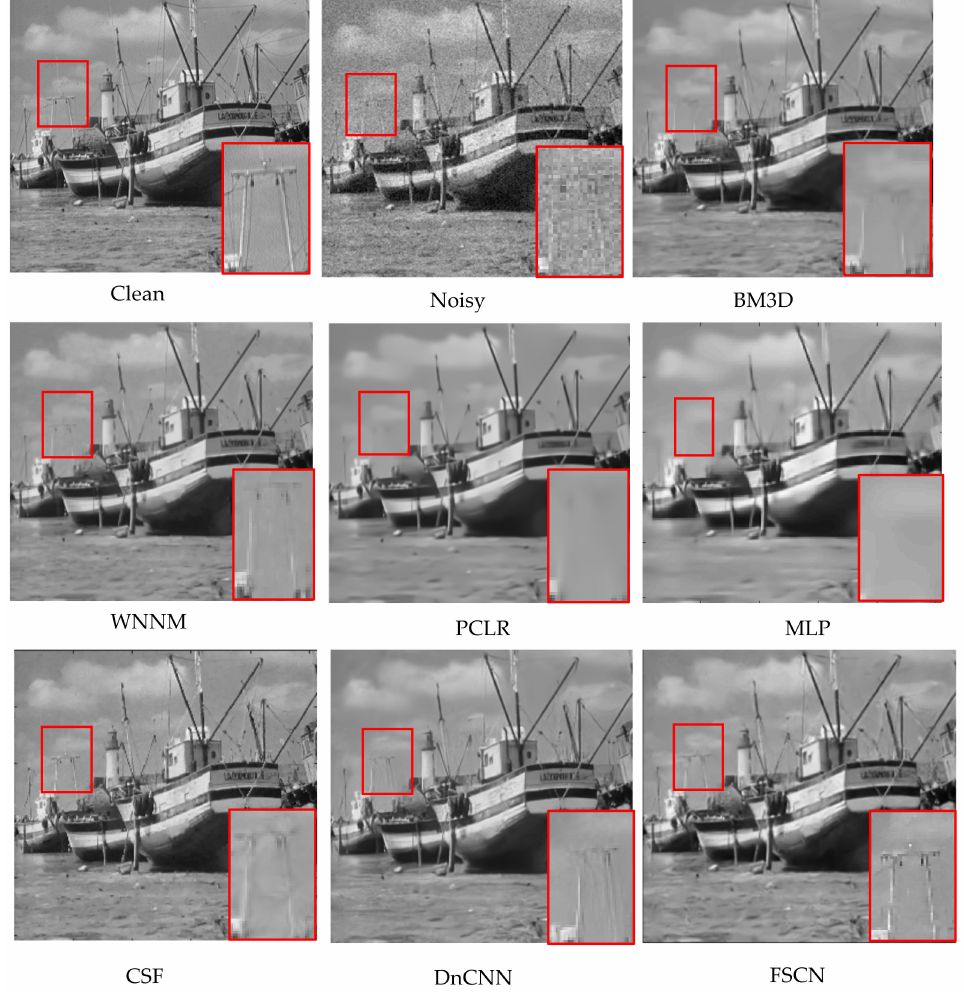
Figure 10. Visual results of image denoising with noise level